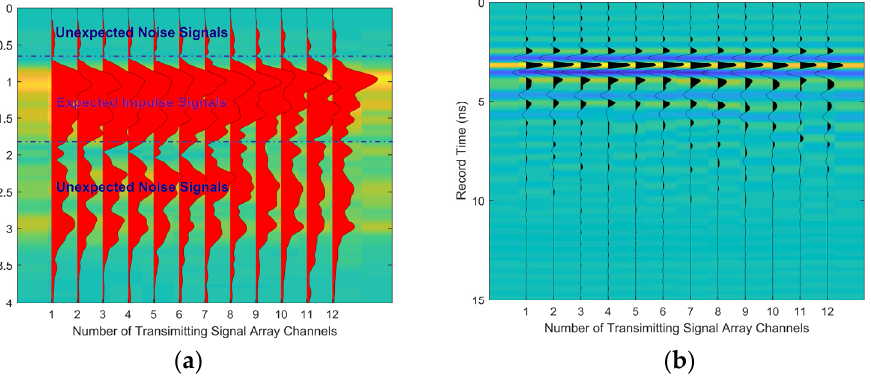
Figure 10. Spectrum analysis: ( a ) corresponding spectrums of 12 emission signals from Vivaldi antennas, and ( b ) emission signals based on the spectral window.